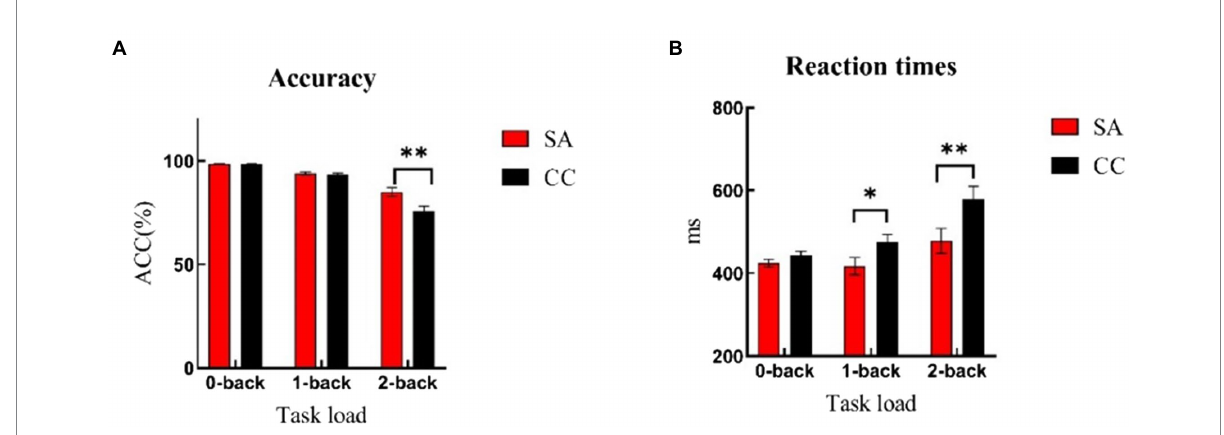
FIGURE 2 Accuracy and reaction times of n-back task under the self-awareness and control groups. Error bar represents the standard error. (A) Self- awareness group showed better accuracy compared with controls in 2-back task. (B) Control group reacted faster than controls both in 1-back and 2-back tasks. * p < 0.05; ** p < 0.01. Red rectangle represents participants of self-awareness group (SA), and black rectangle represents participants of control group